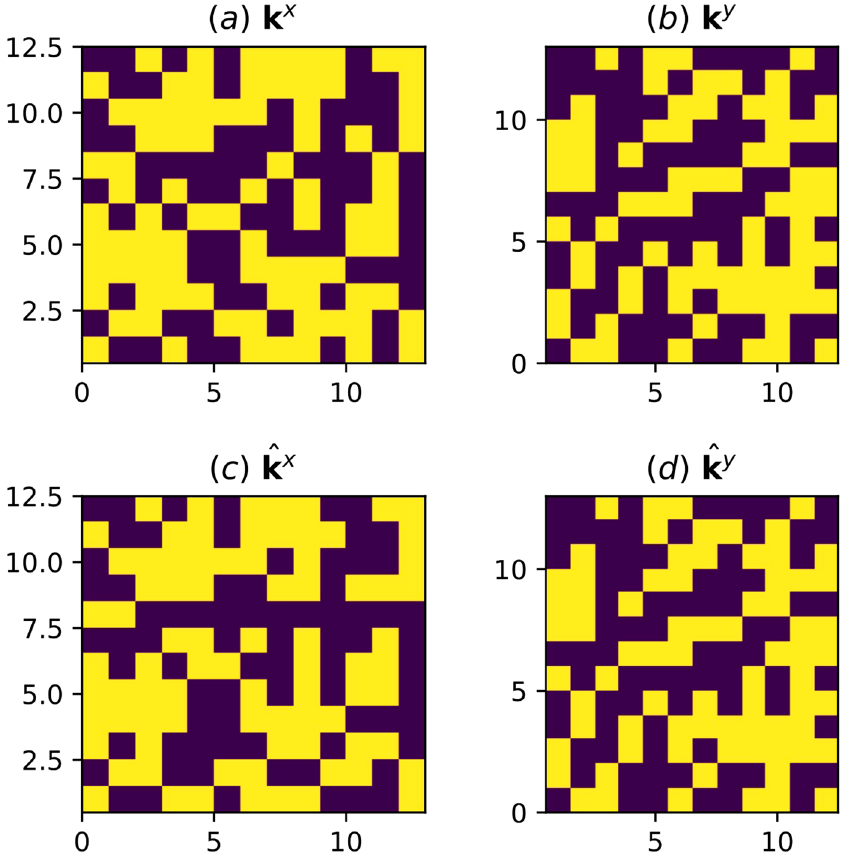
Figure 5. The ( a ) horizontal and ( b ) vertical permeability fields used to generate the hydraulic head observations are shown as is the best inverse result for the ( c ) horizontal and ( d ) vertical permeability. The purple regions have permeability k l and the yellow regions have permeability k h . Note that ˆ = k